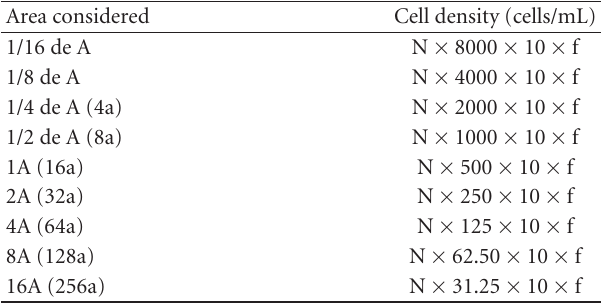
Table 2: Conversion table for counted cells to cells density [11]. Area considered Cell density (cells/mL)